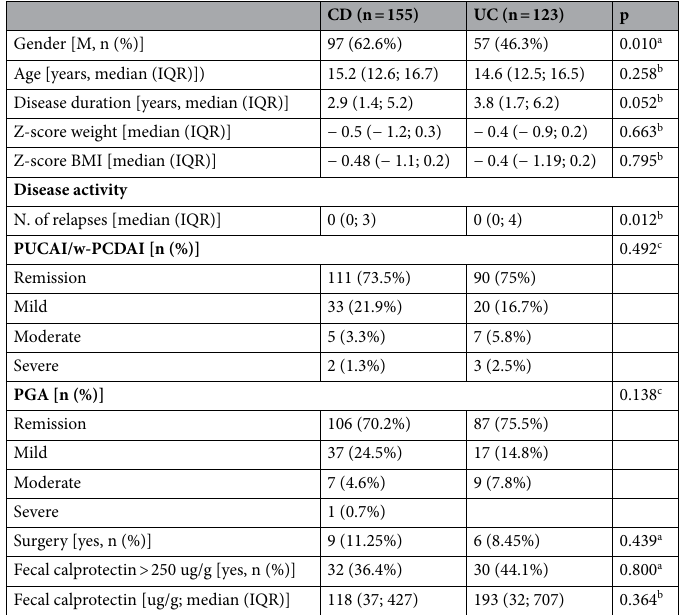
Table 1. Demographic and clinical characteristics of subjects according to type of disease. p-values refer to: a Chi-square test; b Wilcoxon test; c Fisher Exact test. IQR interquartile